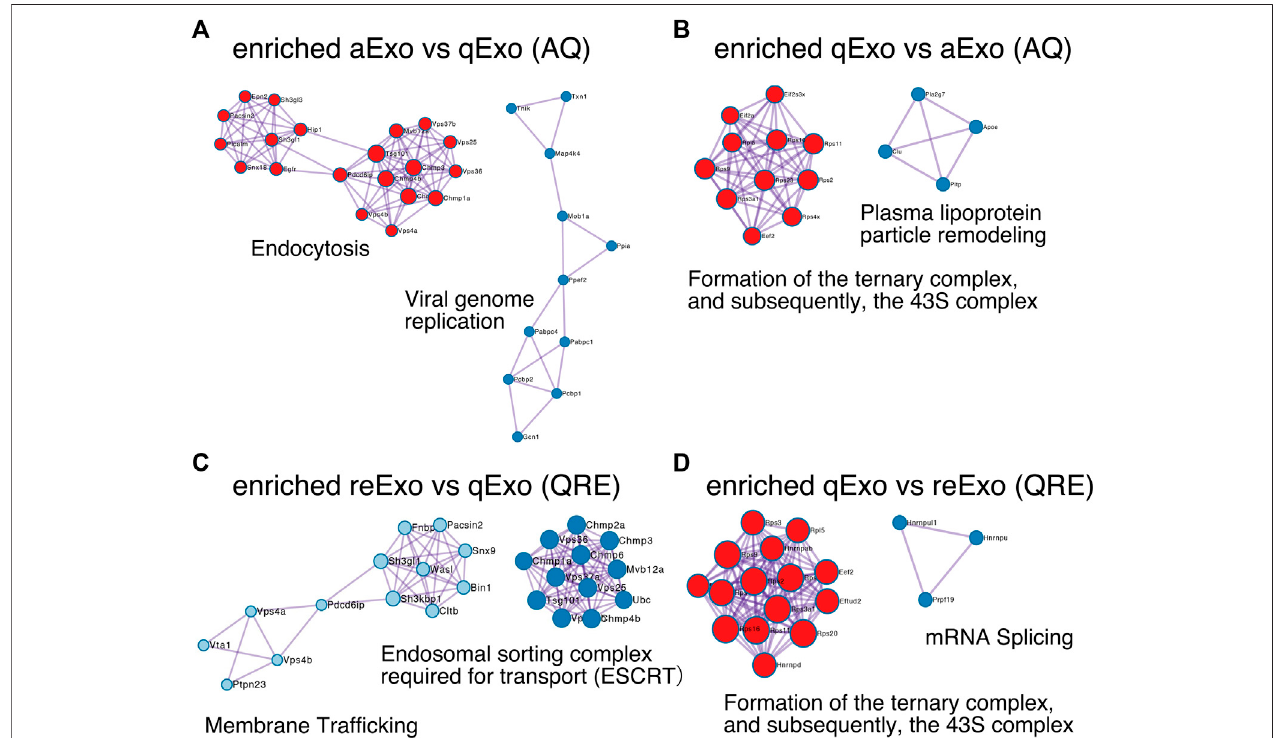
FIGURE 3 | Molecular complex detection networks among enriched proteins. Molecular complex detection networks of putative protein-protein interactions among enriched proteins in exosomes from aNSCs (aExo), exosomes from qNSCs (qExo), and exosomes from reNSCs (reExo). Each node color indicates a different network cluster. (A) Annotations enriched in aExo in aExo vs. qExo (AQ). (B) Annotations enriched in qExo in AQ. (C) Annotations enriched in reExo in qExo vs. reExo (QRE). (D) Annotations enriched in qExo in QRE.